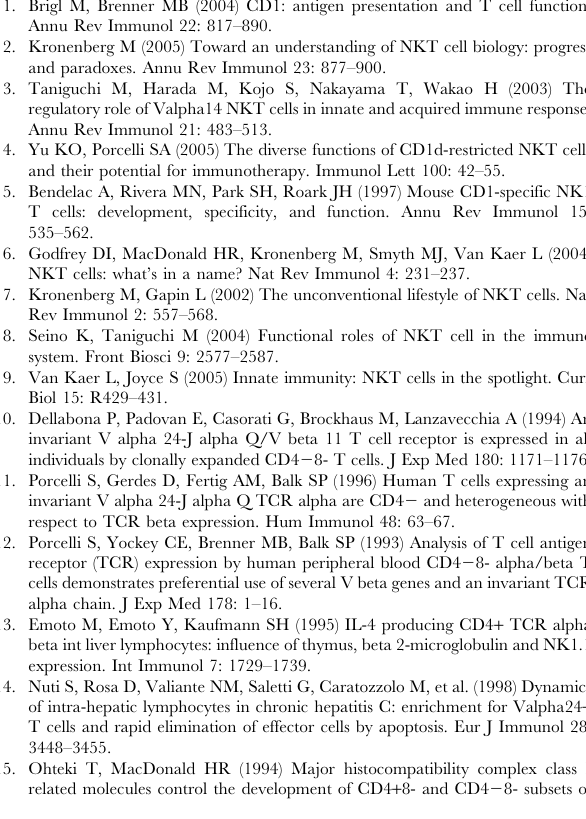
expanded in IL-2-containing media. These cells were re- and anti-CD28 in the presence of GolgiStop (6-8 hrs) and subsequently stained intracellularly with anti-IL-4 (PE) and anti- IFN- c (APC). Figure S2 Cytotoxic capacity of polarized neonatal Th cells. Polarized Th1 or Th2 neonatal lines were generated as in Figure S1. The cytotoxic capacity upon activation at different Th:3T3 ratios of these lines was assayed as in Figure 5B using 20ng/ml SEB for each. Experiments were performed in triplicate per donor; standard deviation is depicted. One representative donor out of three is